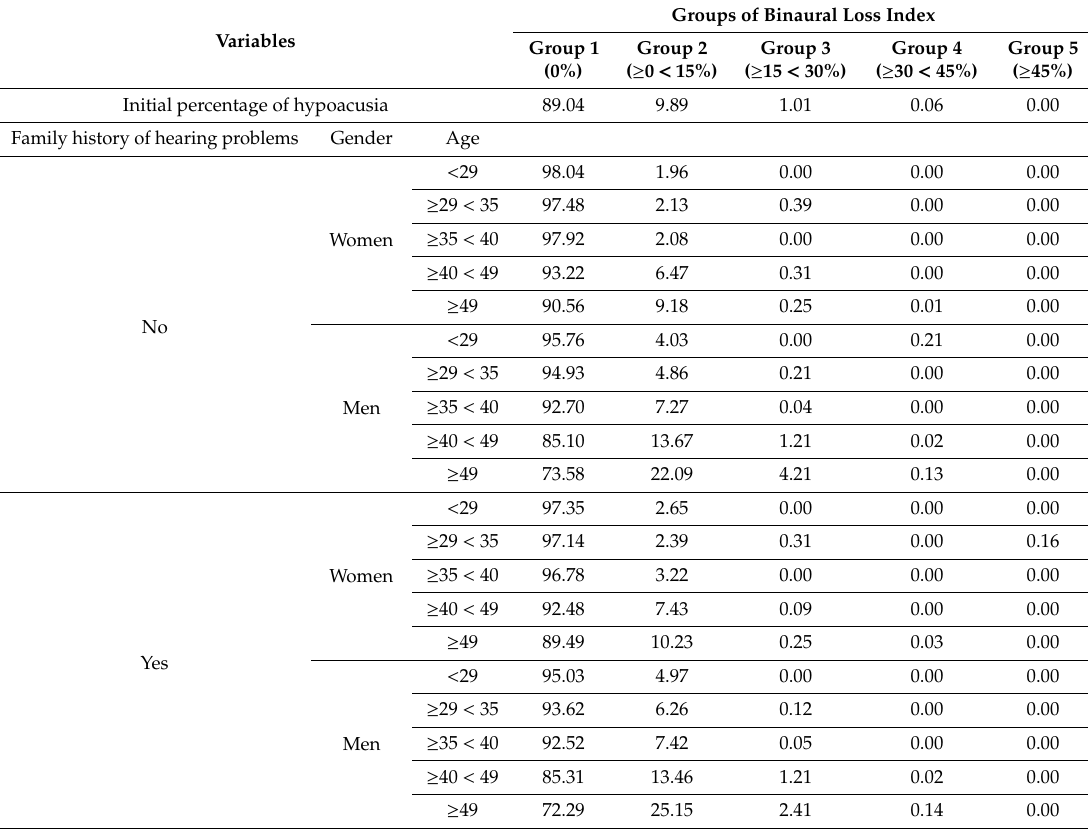
Table 8. Sensitivity analysis. Family history of hearing problems, gender, and age vs. Binaural Percentage Index. Source: Compiled by